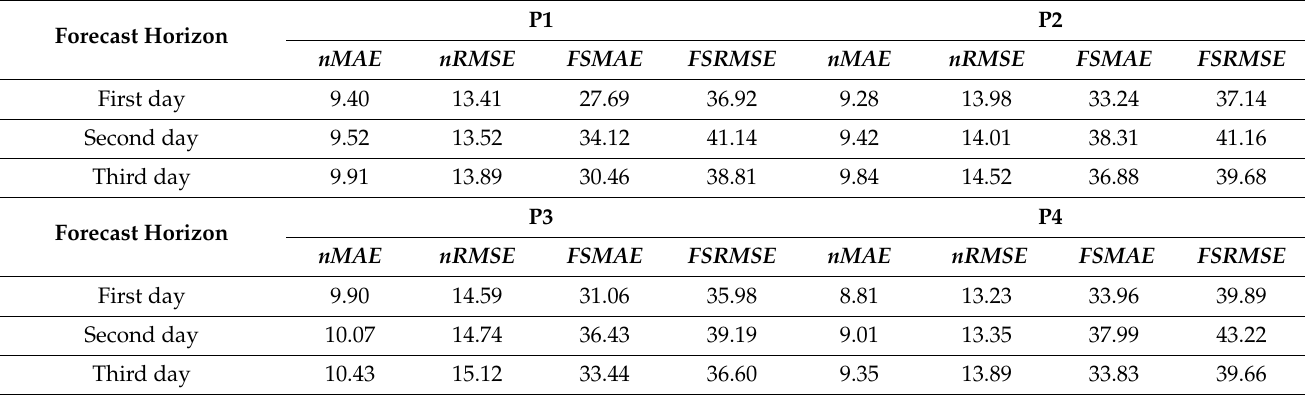
Table 4. nBIAS , nMAE , nRMSE , and SKILLs of the four PV plants. The values are the mean errors, in percentages, regarding the first (horizon of 12–36 h), the second (36–60 h), and the third (60–84 h) day ahead. The errors have been normalized with respect to the maximum measured value ( P1 max = 12.44 kW, P2 max = 15.29 kW, P3 max = 40 kW, P4 max = 13.94